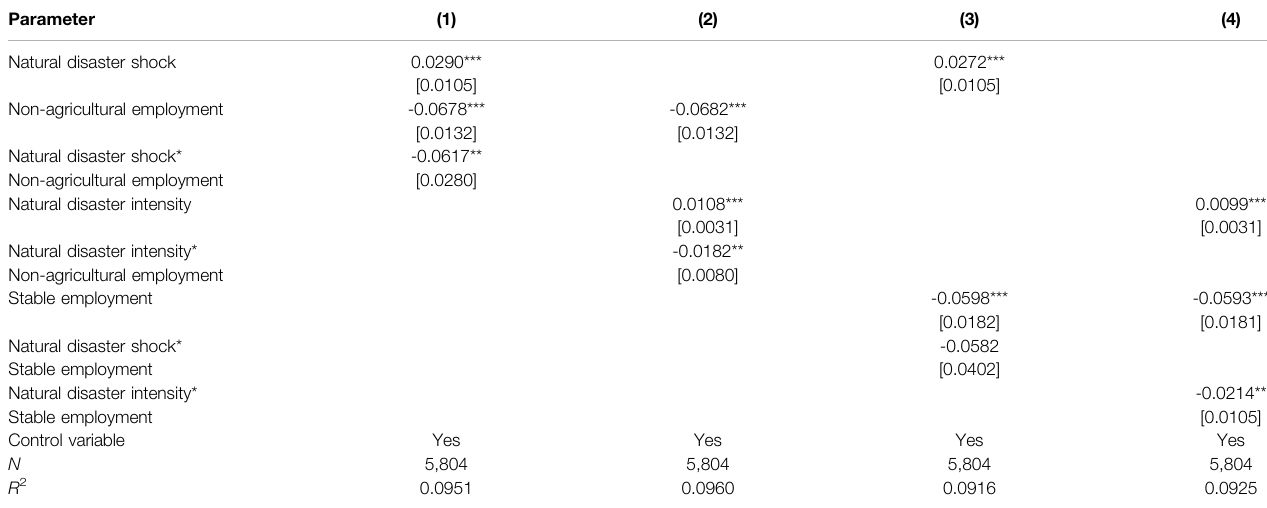
TABLE 5 | Test results of the moderating effect of non-agricultural employment.